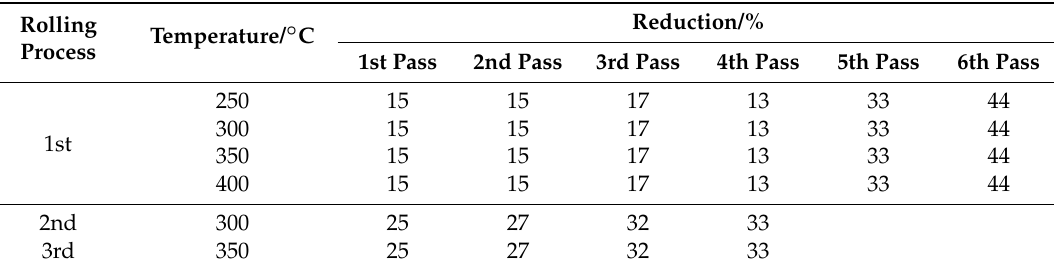
Table 2. Temperatures and reductions of